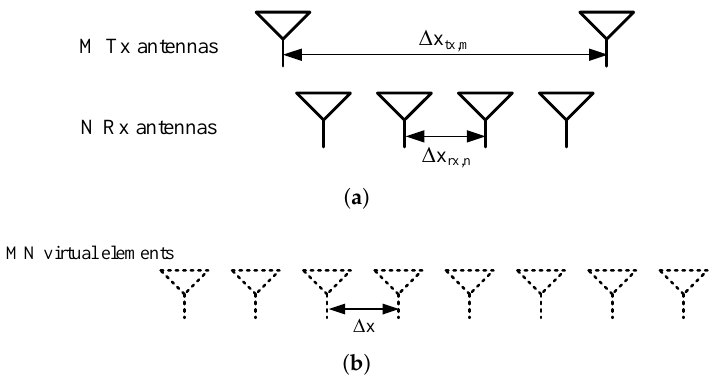
Figure 7. Antenna geometry: ( a ) The actual array; ( b ) The equivalent virtual array. Tx: transmitting; Rx: receiving.